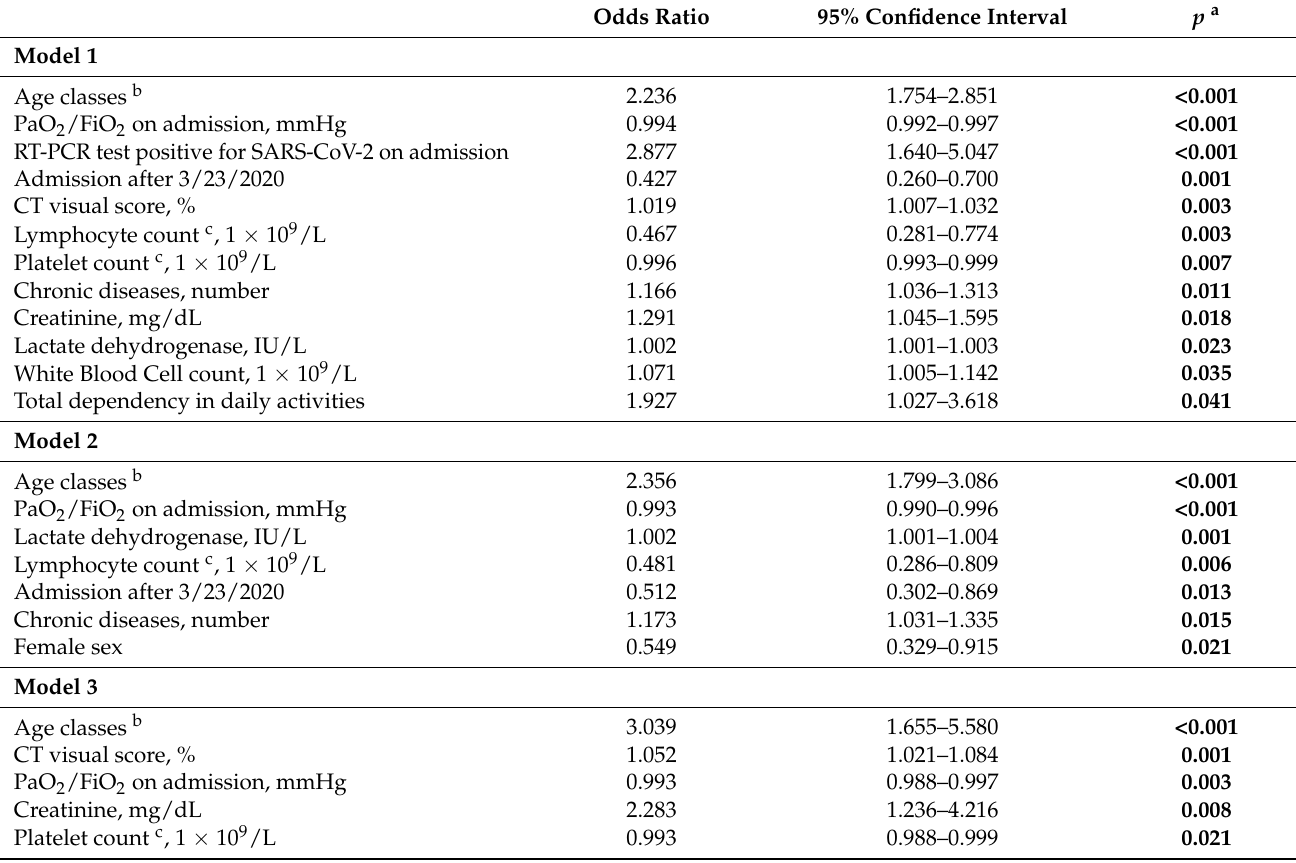
Table 7. Stepwise logistic regression model with forward selection, testing factors independently associated with hospital mortality. Model 1: all participants included in the study were considered (1264 patients). Model 2: only participants who tested positive at RT-PCR for SARS-CoV-2 on admission were considered (807 patients). Model 3: only participants who tested negative at RT-PCR for SARS-CoV-2 on admission were considered (422